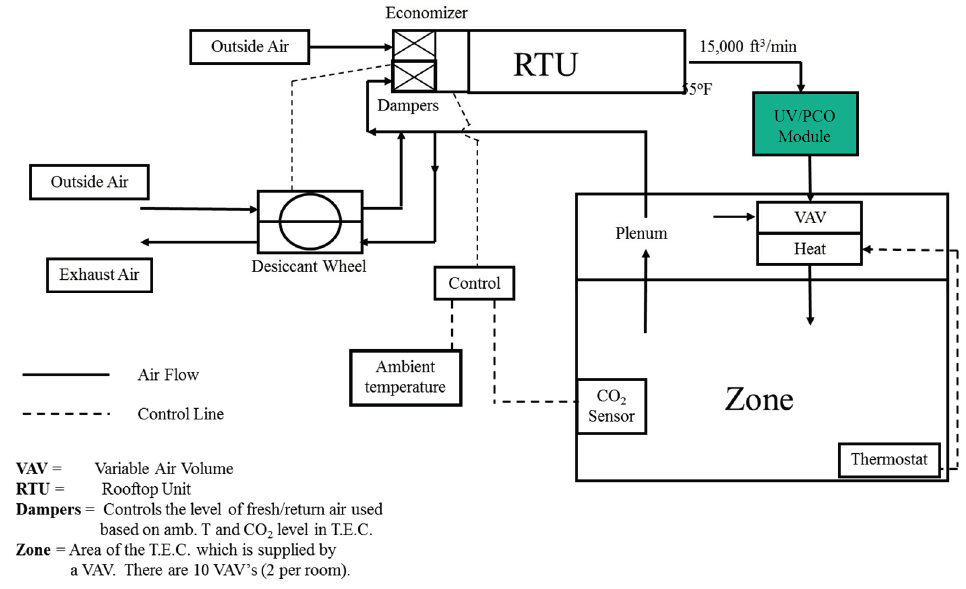
Figure 9. HVAC Schematics of air purifier installation; 35 ton rooftop with VAV, economizer and desiccant